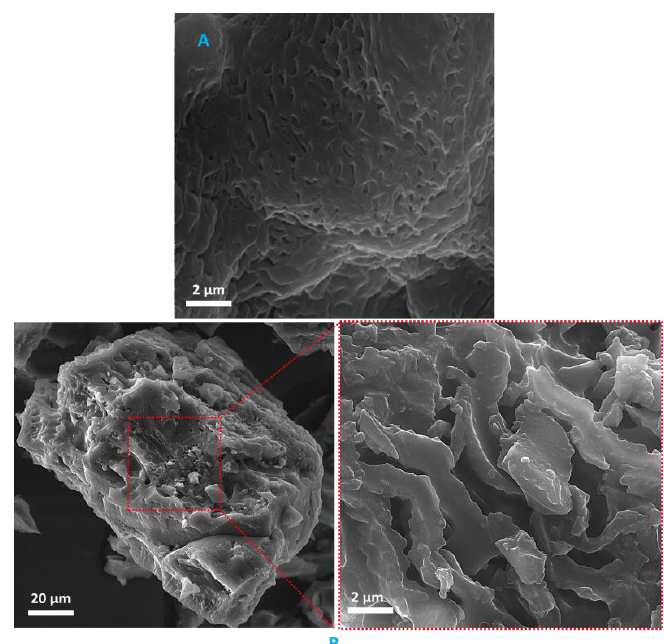
Figure 1. Schematic illustration of preparation of BC@GCN-P-IL.